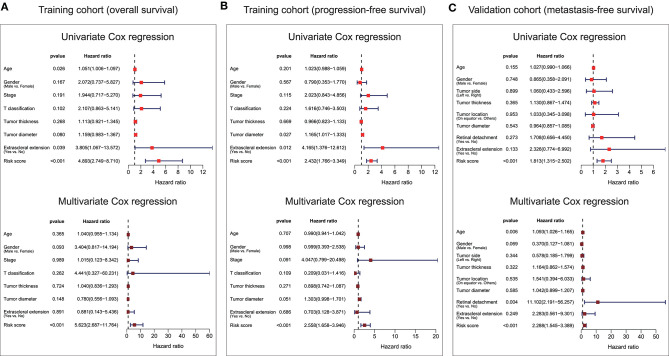
Forest plot summary of univariate and multivariate Cox analyses of prognosis. Univariate (upper) and multivariate (bottom) analyses were carried out using the ten-gene signature and clinical covariates in the training cohort based on overall survival (A), training cohort based on progression-free survival (B), and validation cohort based on metastasis-free survival (C). Colored solid squares represent HR, and the horizontal line across the HR represents the 95% CI. All p-values were calculated using the Cox regression hazards analysis. HR, hazard ratio; 95% CI, 95% confidence interval.